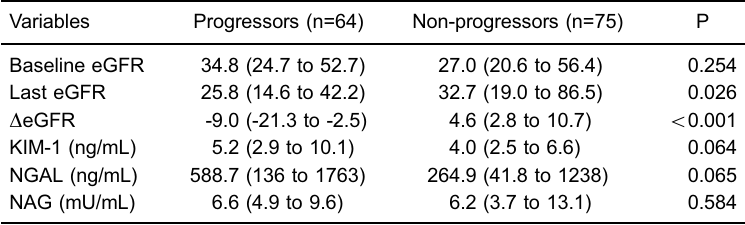
Table 3. Renal function at baseline and last follow-up and the urinary levels of KIM-1, NGAL, and NAG in patients who progressed to worse CKD stages compared to patients who did not